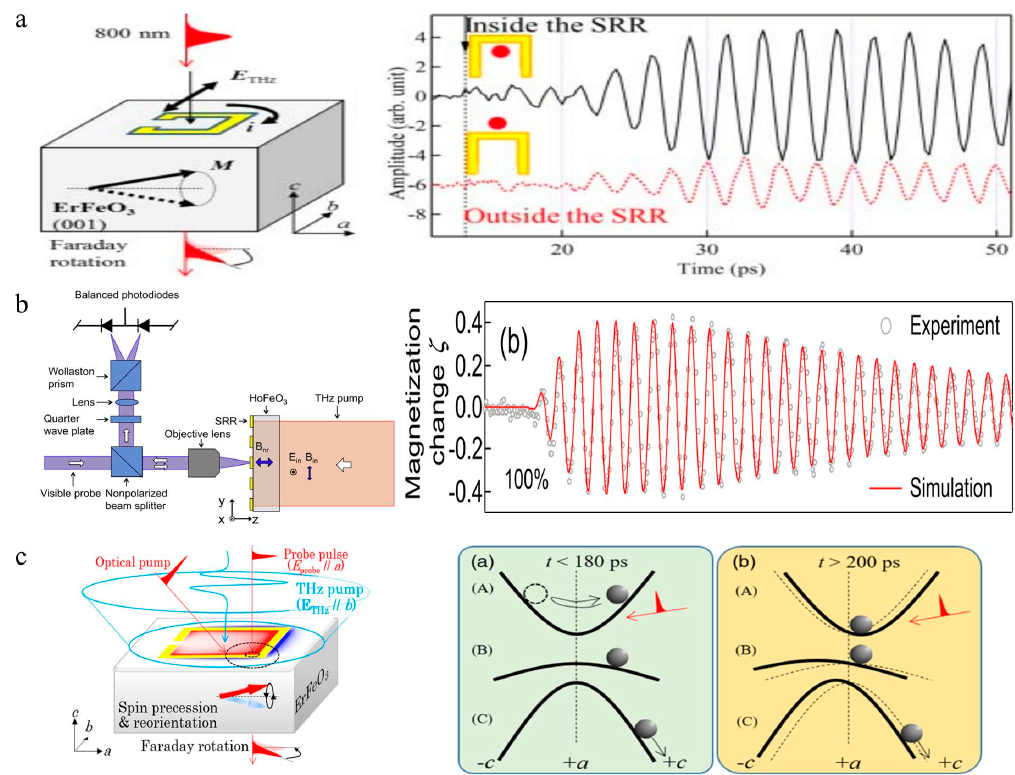
Figure 16. ( a ) Exciting the antiferromagnetic mode using the terahertz magnetic field of the SRR. Therightfigureshowsthatthespinprecessionmeasurestheinternal(blacksolidcurve)andtheouter(red dottedcurve)SRR.Obvious180phasedi ff erencesandamplitudechangeswereobserved[186], copyright IEEE, 2012. ( b ) Schematic setup of THz pump-visible MOKE measurements. The relationship between the magnetization change and time is obtained by experiment and simulation [187]. ( c ) Experimental configuration using the SRR structure. The right side shows the dominant process of symmetry destruction in the terahertz magnetic field. The magnetization tilt is caused by the free spin precession and non-resonant field excitation forced oscillation [188], copyright American Physical Society,